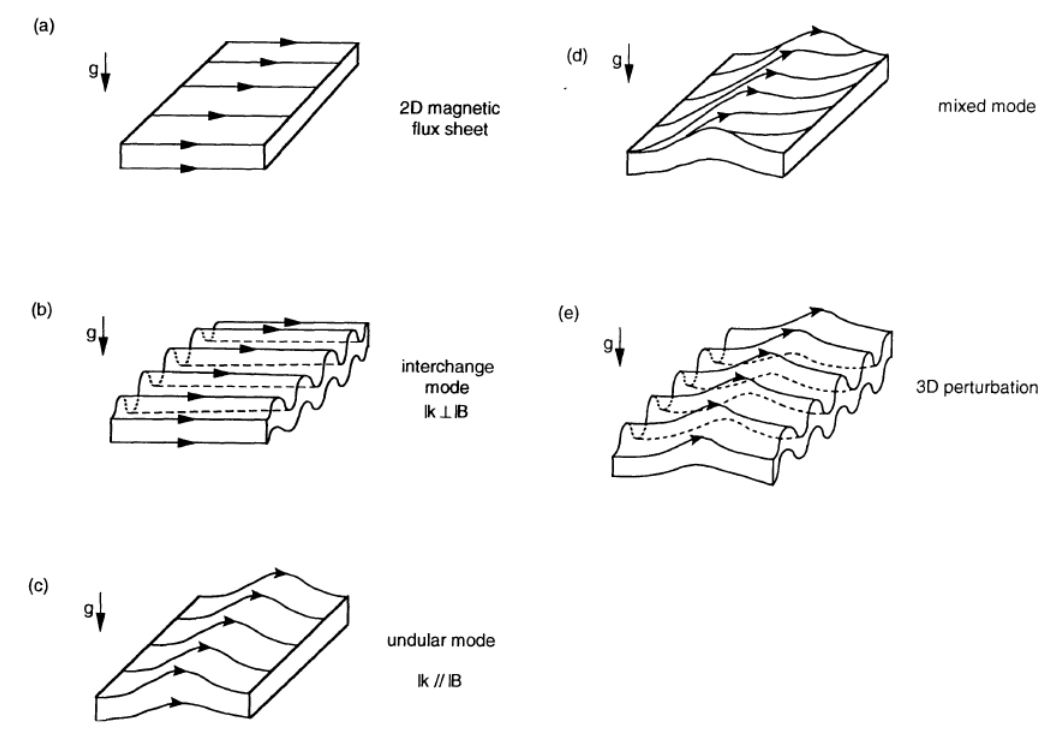
Figure 14: Schematic illustration of the different modes of the magnetic buoyancy instability of a hori- zontal flux sheet. Image reproduced with permission from Matsumoto et al. (1993), copyright by